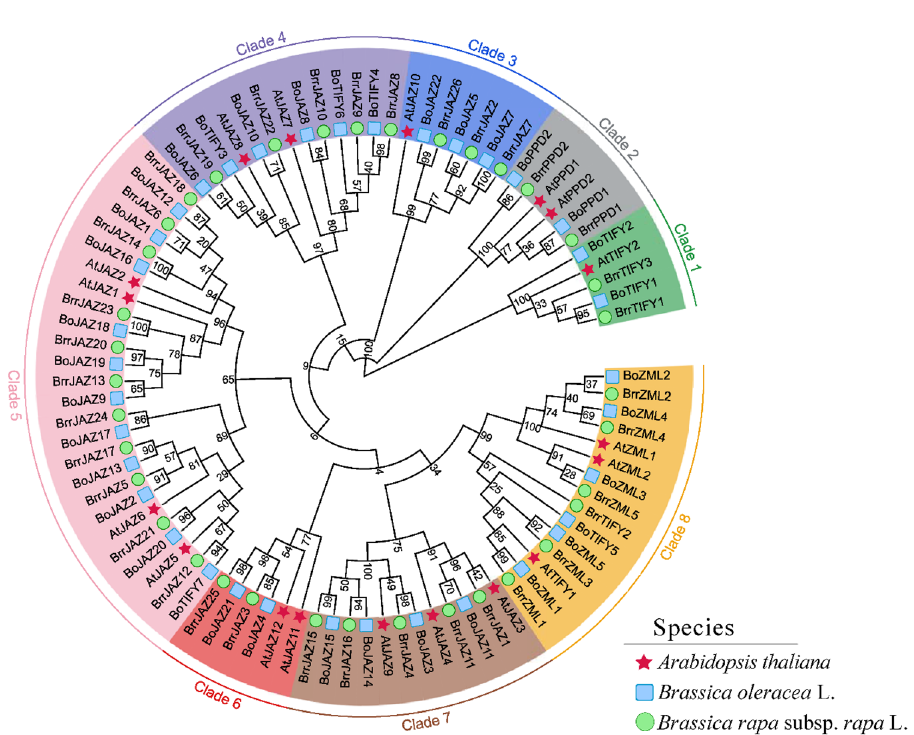
Figure 2. Phylogenetic relationship of JAZ protein sequences of turnip and its related species. The predicted full-length amino acid sequences of and 18 AtJAZ, 36 BrrJAZ, and 36 BoJAZ were used to construct a phylogenetic tree using MEGA 7 by the neighbor-joining